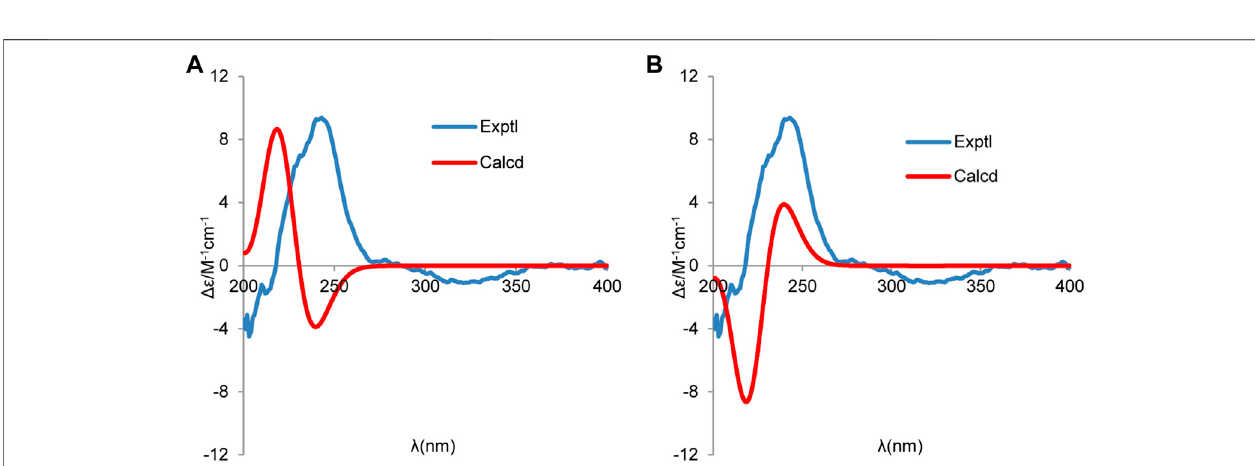
FIGURE 5 | Experimental and calculated ECD spectra of (A) (1 R ,4 R ,5 S ,11 R ) and (B) (1 S ,4 S ,5 R ,11 S ) (red, calculated at the B3LYP-PCM/6-31G(d,p)//B3LYP/6- 31G (d,p) level in CH 3 OH; blue, experimental in CH 3 OH).